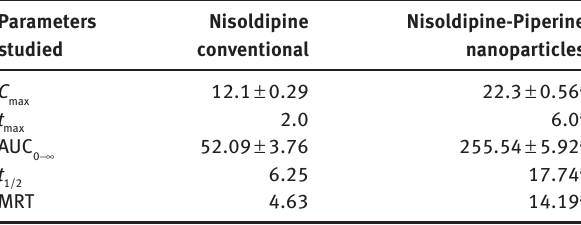
Table 7: Pharmacokinetic profile of nisoldipine-piperine nanoparti- cles and nisoldipine conventional